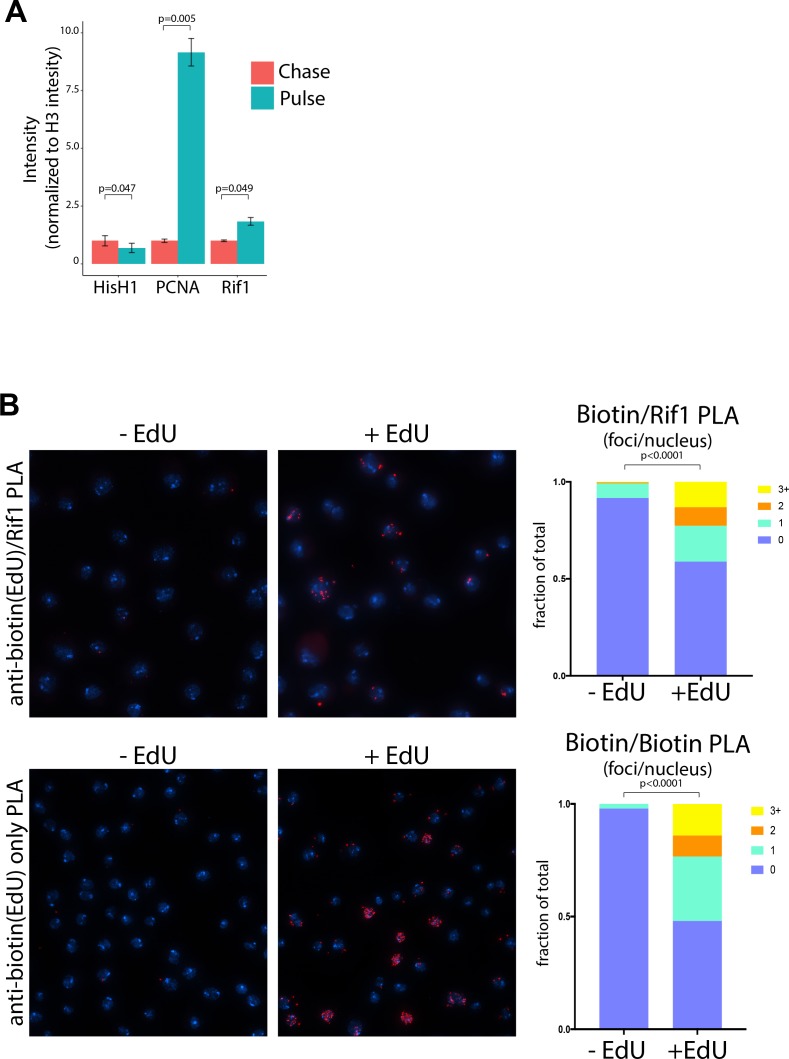
Rif1 localizes to replication forks in cultured cells.(A) Quantification of protein intensity from iPOND mass spec data in cultured S2 cells. Intensities represent the summed MS1 spectrum for each peptide identified for Histone H1, PCNA or Rif1. Each sample was normalized to the protein intensity for Histone H3 to account for differences in protein abundance between each sample. Bars represent the average of three biological replicates and the error bars are the S.E.M. A paired t test was used to determine significance. (B) Proximity Ligation Assay (PLA) with nascent chromatin in cultured S2 cells reveals a signal between biotinylated EdU (nascent DNA) and Rif1. Representative images from anti-biotin and anti-Rif1 assay in the presence or absence of an EdU pulse. As a positive control, mouse and rabbit anti-biotin antibodies were used together in the presence or absence of an EdU pulse. Number of PLA foci per nucleus in quantified. Quantification of two biological replicates were used per condition. N (total number of nuclei counted)=775 for –EdU and 669 for + EdU (Biotin only). N = 773 for –EdU and 406 for + EdU (Rif1 and Biotin). A two-tailed Welch’s t test was used to determine significance.10.7554/eLife.39140.029Figure 6—figure supplement 2—source data 1.Data for Figure 6—figure supplement 2B.